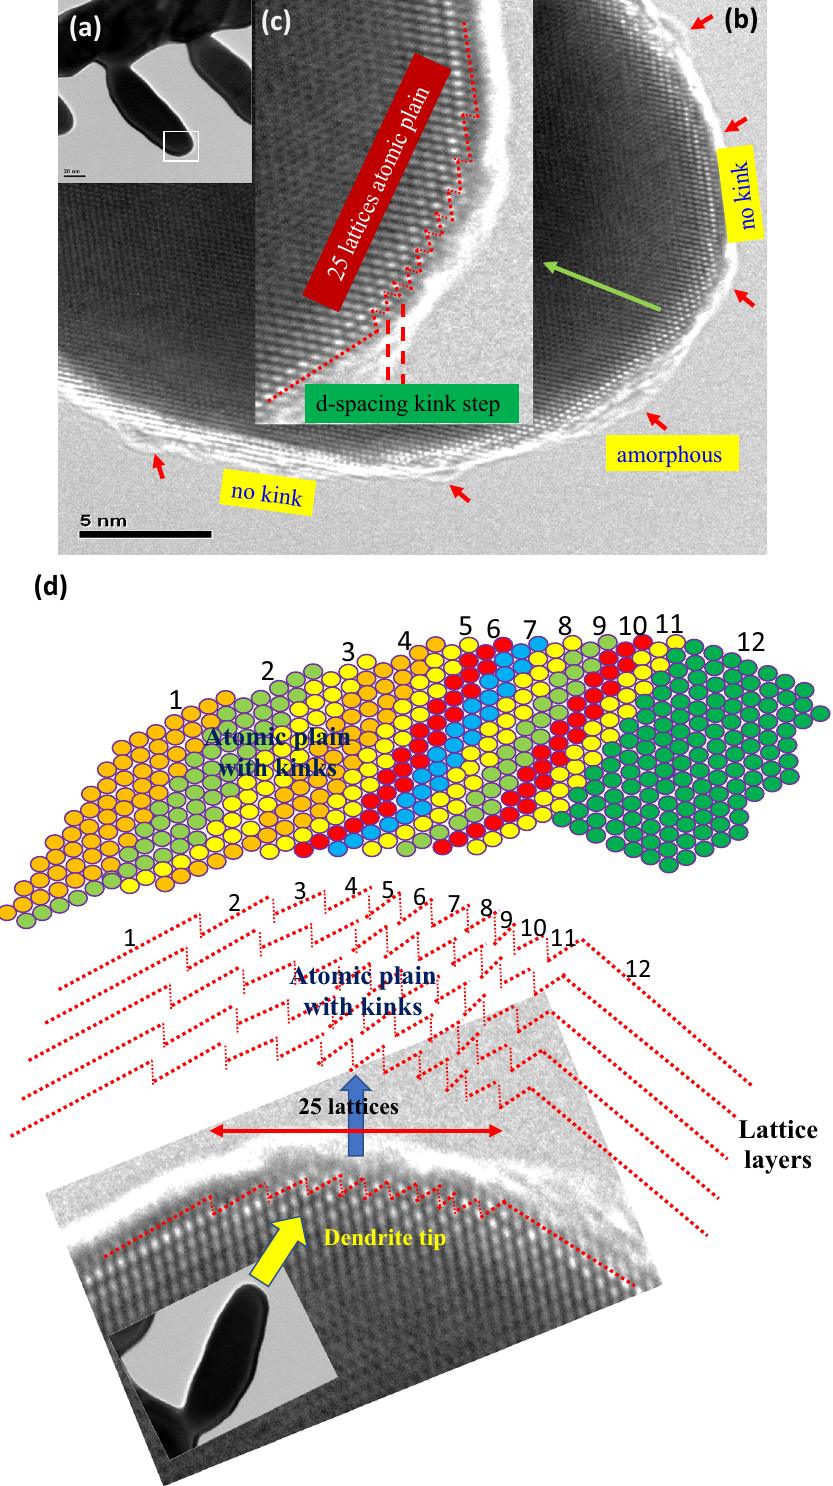
Figure 5. ( a ) The dendrite arm without globule attachment still exhibited growth behavior indicative of a high aspect ratio. The growth behavior was closely related to the high surface energy of the tip area, which enabled rapid adsorption of atoms. ( b ) The high- resolution TEM image reveals the rim of the amorphous nano covering surrounding the curved region of the arm tip, as indicated by red arrows. The upper right top and lower left bottom show straight linear lattice structure with no kinks. ( c ) The tip end shows zig-zag kink steps for which the kink step has a one d-spacing. The zig-zag structure area is comprised of 25 lattices forming an atomic plane when extended two dimensionally. ( d ) Top view simulation sketch presents the 25 lattices atomic plane on the dendrite tip with an average roughness (Ra) of one d-spacing and the fronts of the lattice segment from the atomic plane. The kinks provided the high surface energy for atom adsorption that favored the growth of the secondary dendrite arm in the longitudinal direction. The numbered planes show extending segment of the underneath lattice plane that form the zig-zag structure. The round curvature of the dendrite tip is formed with short segments, planes